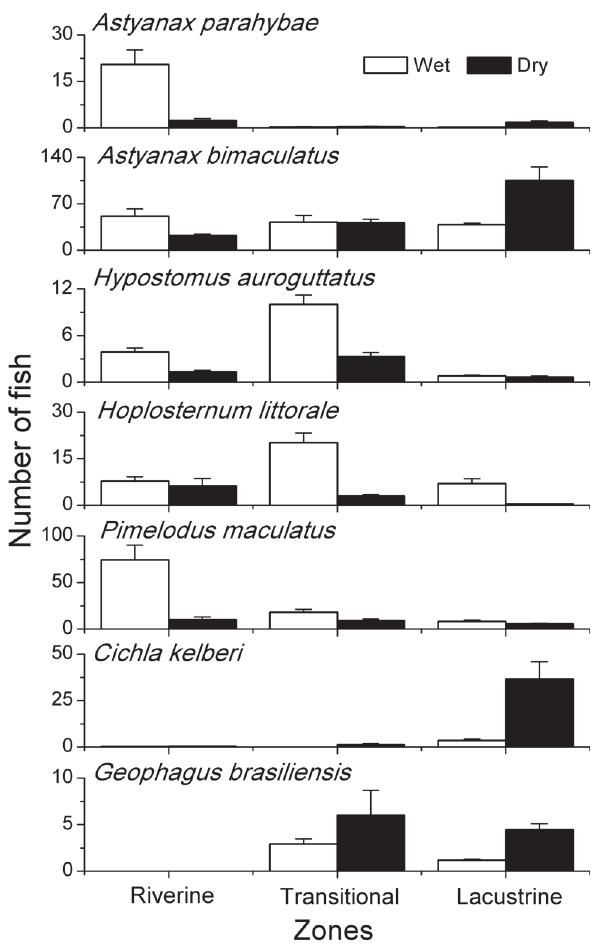
Figure 3. Average values and standard error (vertical lines) for fish species that differed significantly among zones and